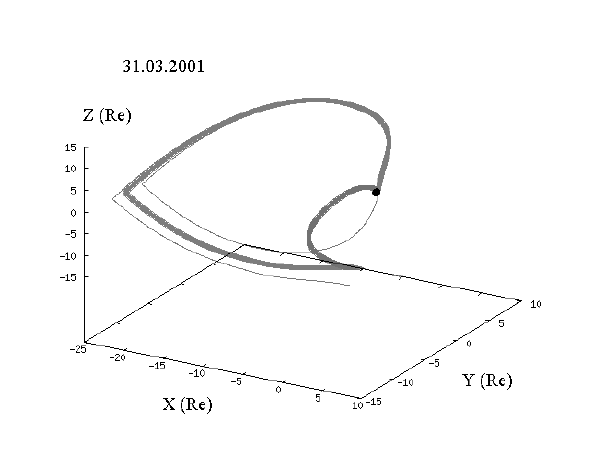
Fig. 4. Magnetic field lines (bold curves) going from the northern polar cap boundary to the southern magnetic field neutral point cal- culated in the paraboloid model of the terrestrial magnetosphere. The closest to the bold line going through the tail closed and open field lines are marked by thin curves. X , Y , and Z are the axes in the solar-magnetospheric coordinate system; distances along them are measured in the Earth’s radii ( R E ). Calculations are performed for the 31 March 2001 event.